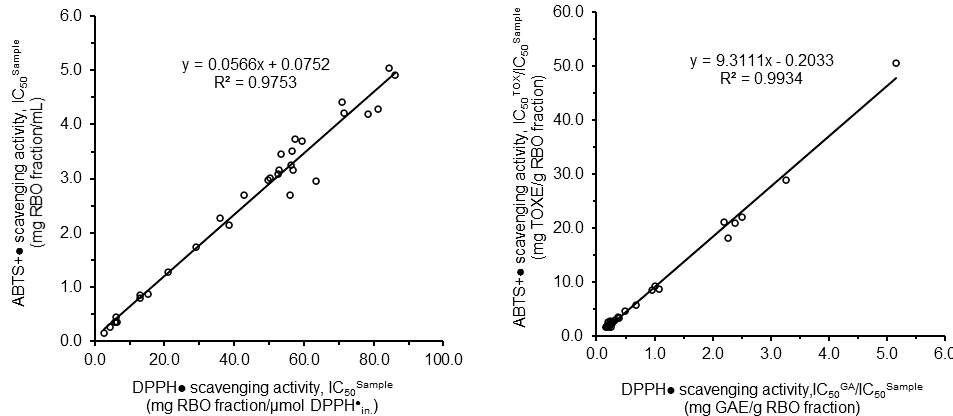
Figure 8. Correlation between ABTS and DPPH assays for Hex-RBO analysis.